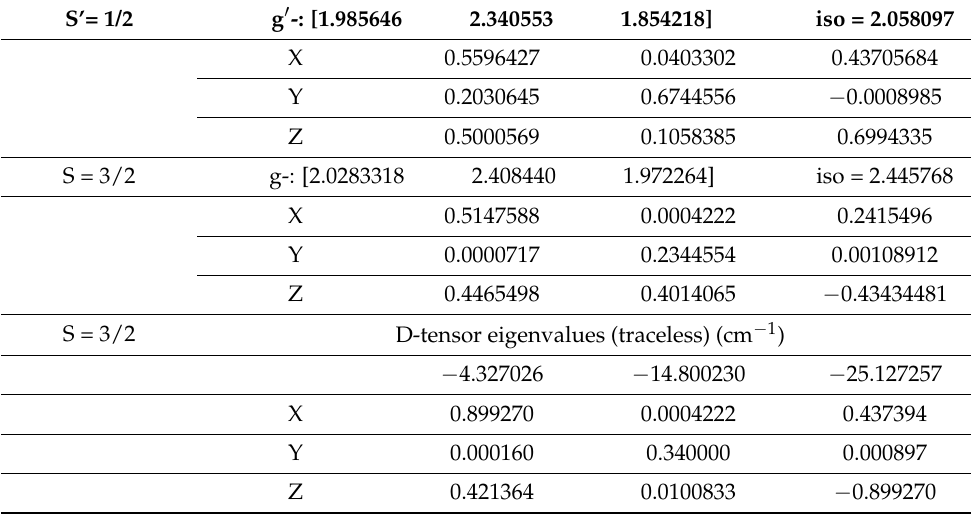
Table 7. The calculated parameters for anistropic magnetic parameters.